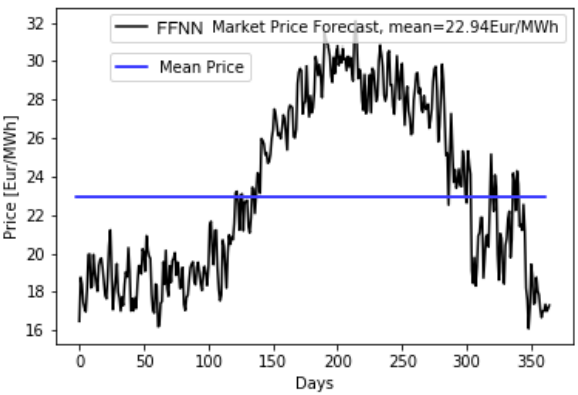
Figure 6. Forecasted electricity prices in MIBEL for 2030 and the yearly average price.